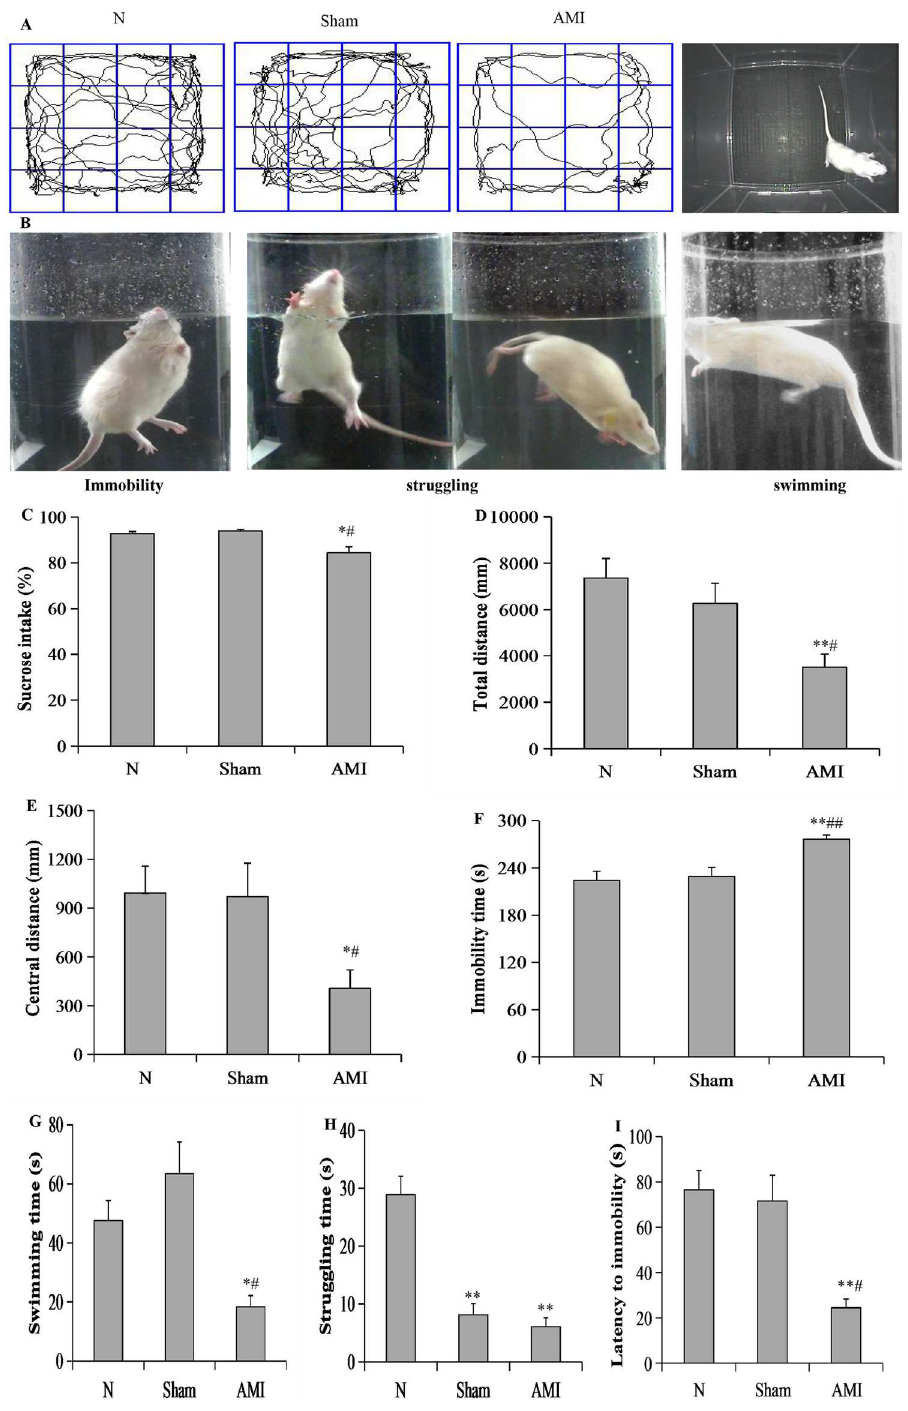
Fig 3. Behavioral measures. (A, B) Representative images of the observedrat behaviorsin the open field test (OFT) and forced swim test (FST). (C) Sucrose intake in the 3 groups. (D-E) Total and central distancein the 3 groups. (F-I) Immobility, swimmingtime, strugglingtime, and latency to immobilityin the 3 groups. Data are presented as means ± S.E.M (n = 8 per group). * P < 0.05 and ** P < 0.01 vs. N group; # P < 0.05 and ## P < 0.05 vs. Sham